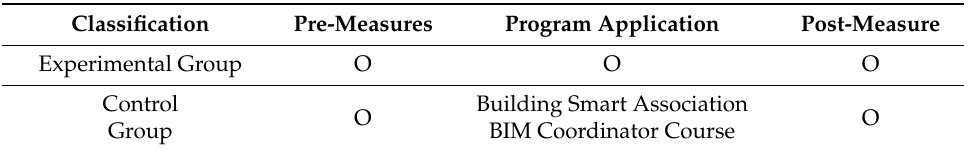
Table 8. Experiment